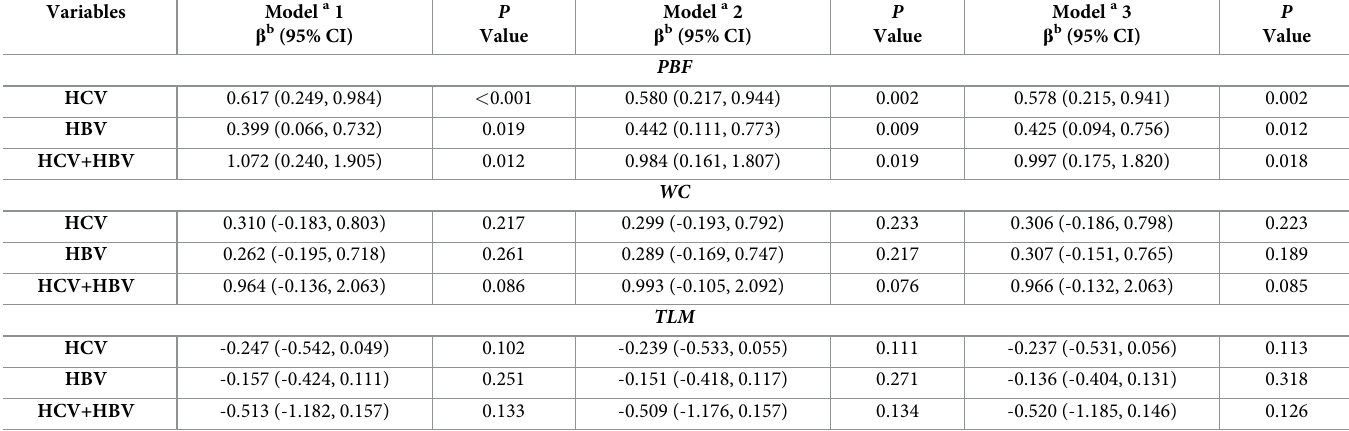
Table 2. Association between hepatic infection and anthropometric parameters.